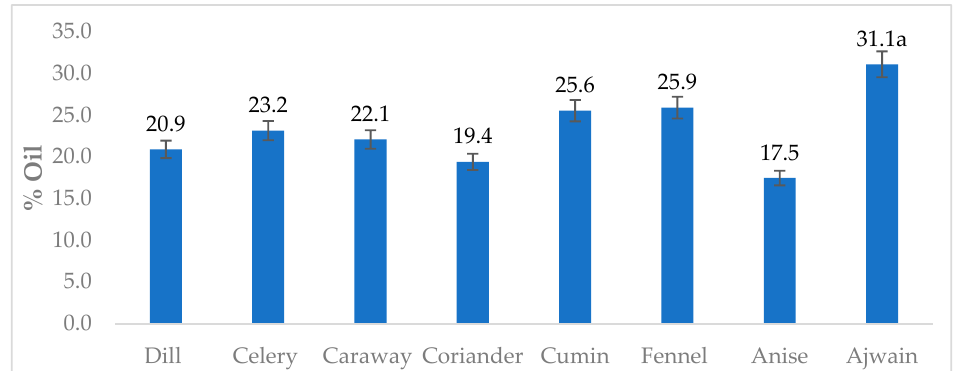
Figure 1. The oil contents (%, dry weight basis) recorded in the Apiaceae family spices. The values are mean ± standard deviation, from an average of six determinations. a The mean value is significantly highest among the studied spices ( p < 0.05; Turkey HSD).